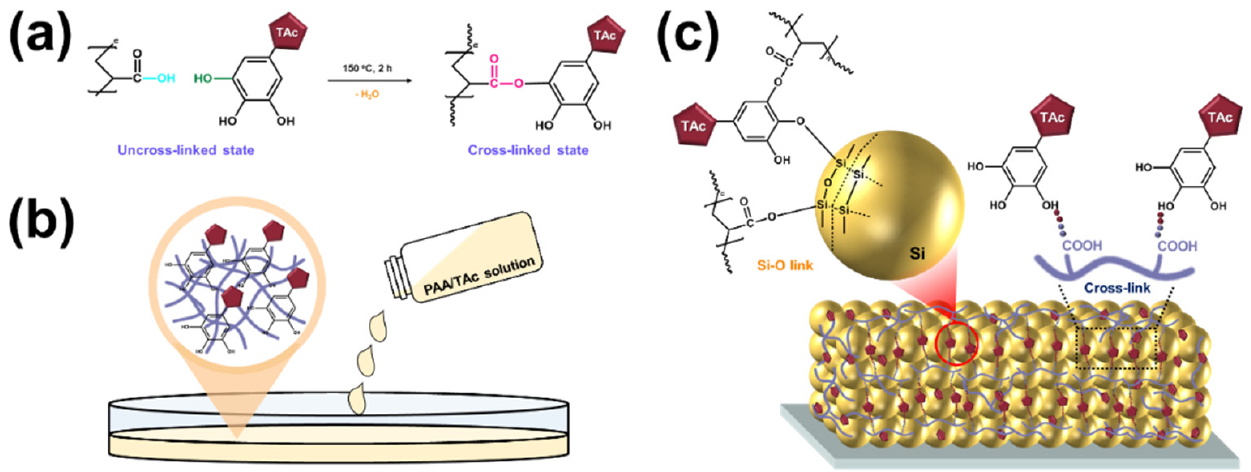
Figure 1. Schematic illustration showing preparation of binder using poly(acrylic acid) (PAA) and tannic acid (TAc): ( a ) PAA and TAc structure; ( b ) preparation of PAA and TAc solution; ( c ) nano-sized Si particles and interaction between C-PAA and TAc.